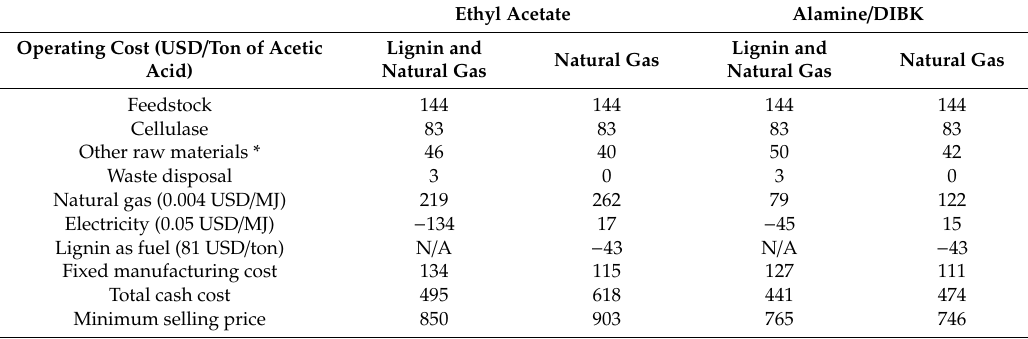
Table 6. Cash operating cost and minimum selling price for a biorefinery with a capacity of 120,650 tons acetic of acid / year. Ethyl Acetate Alamine /